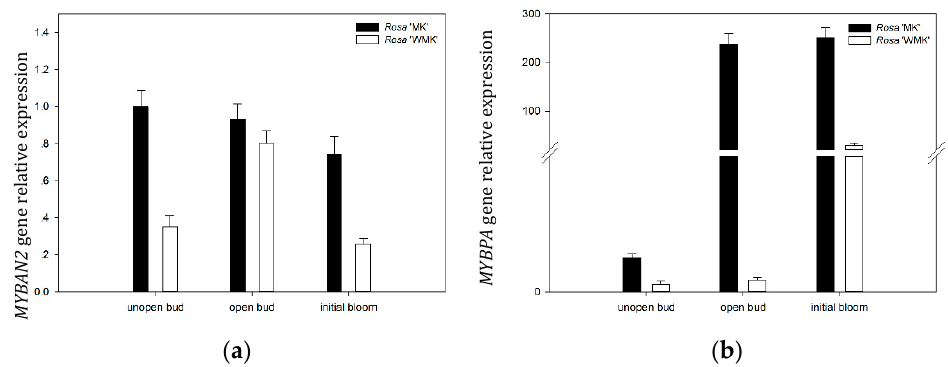
Figure 7. Gene expression level of ( a ) RmMYBAN2 and ( b ) RmMYBPA of the Rosa ‘Margo Koster’ and Rosa ‘White Margo Koster’ during flowering (unopened bud, opened bud, and initial bloom). The expression level of each gene is relative to that of ACTIN reference in Rosa ‘Margo Koster’ at unopen bud stage. Each data point is the average of three biological repeats. Error bars indicate SDs.